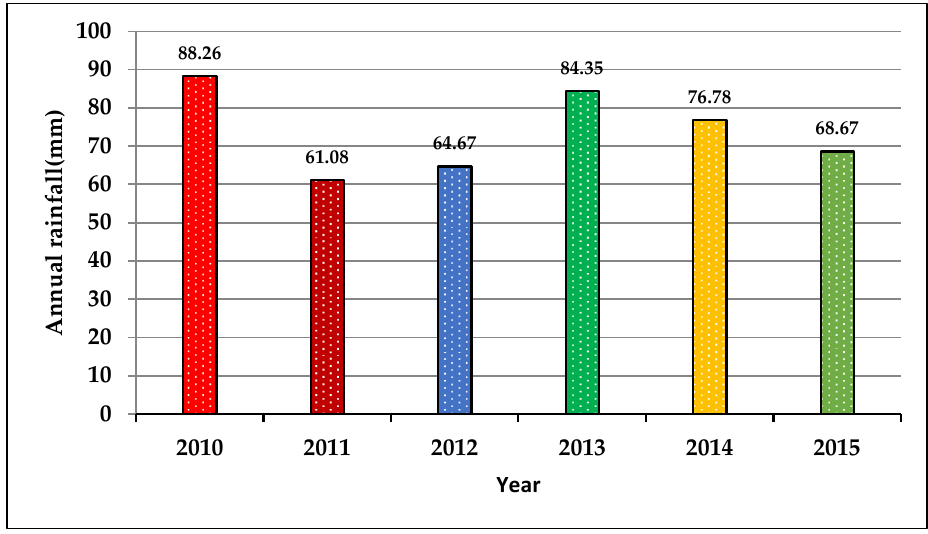
Figure 7. Annual rainfall pattern from 2010 to 2015 in the study area.